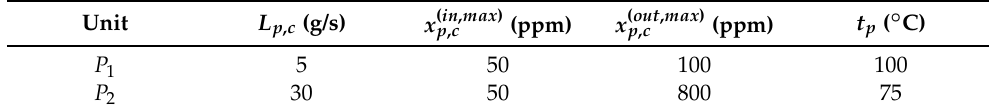
Table 1. Process water-using units data for motivation example.